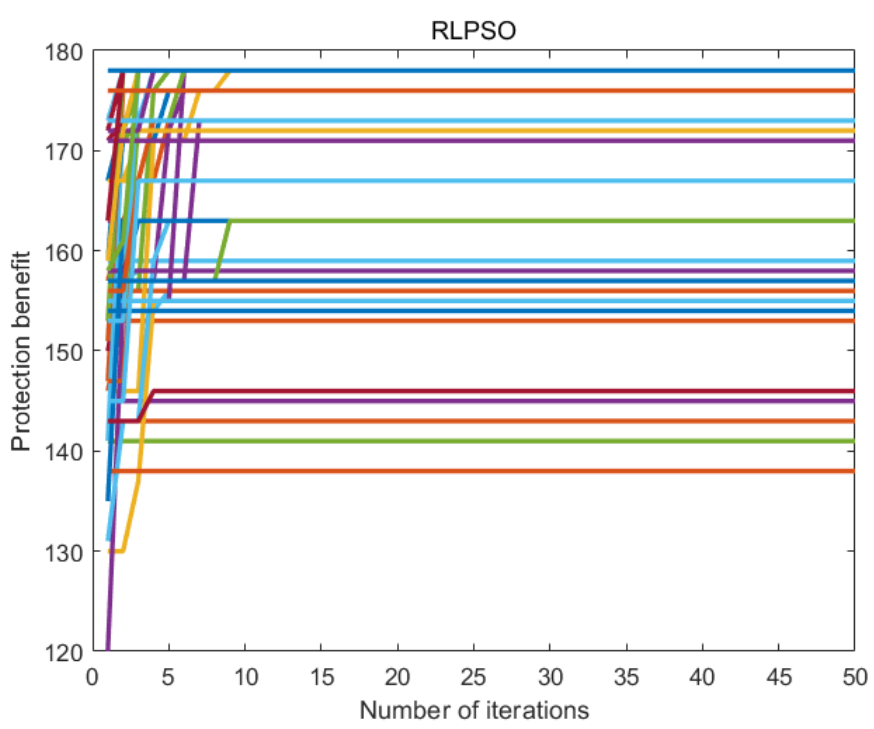
Figure 7. Population size is 15, and the RLPSO algorithm is run 100 times.